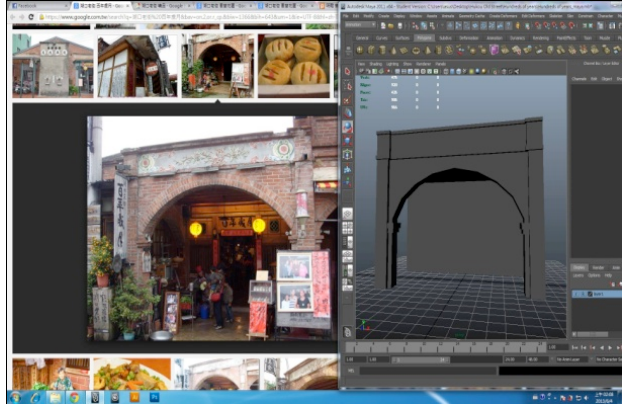
Figure 3. Modeling in 3ds Max (right) and building reference materials (left)